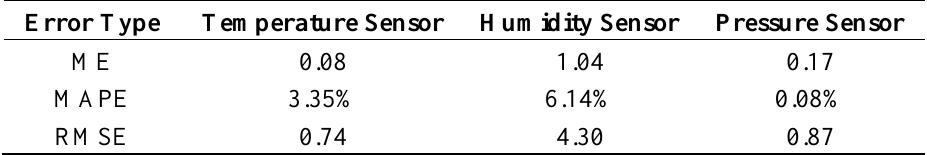
Table 3. Option 1 error analysis after MAPE factor adjustment.